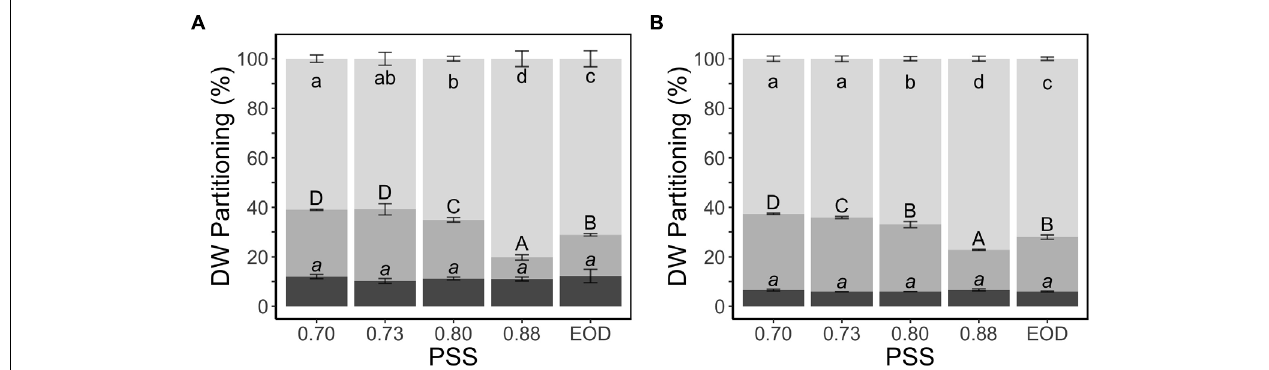
FIGURE 3 | Dry weight partitioning (%) to different plant organs of tomato plants in relation to four levels of PSS and an EOD-FR treatment in EXP1 (A) and EXP2 (B) . Plants had been grown for 4 weeks at the different light treatments. Error bars represent SEM ( n = 3). Different letters (lower case for leaves, capitals for stem and lower-case italics for roots) indicate significantly different means ( P <